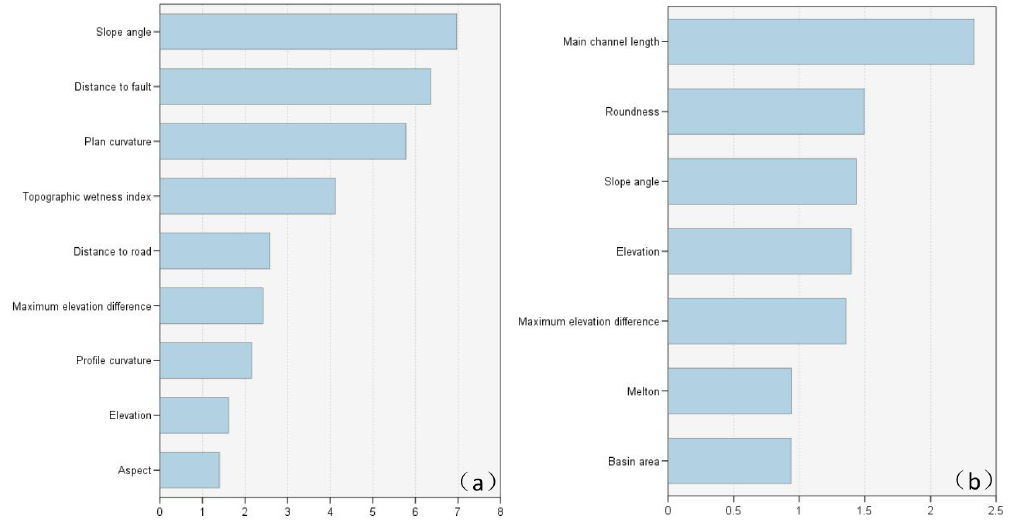
Figure 10. Parametric importance graphics obtained from the RF model: (a) parametric importance graphics of landslide and (b) parametric importance graphics of debris flow. Table 4. Variable importance assigned for debris flow.